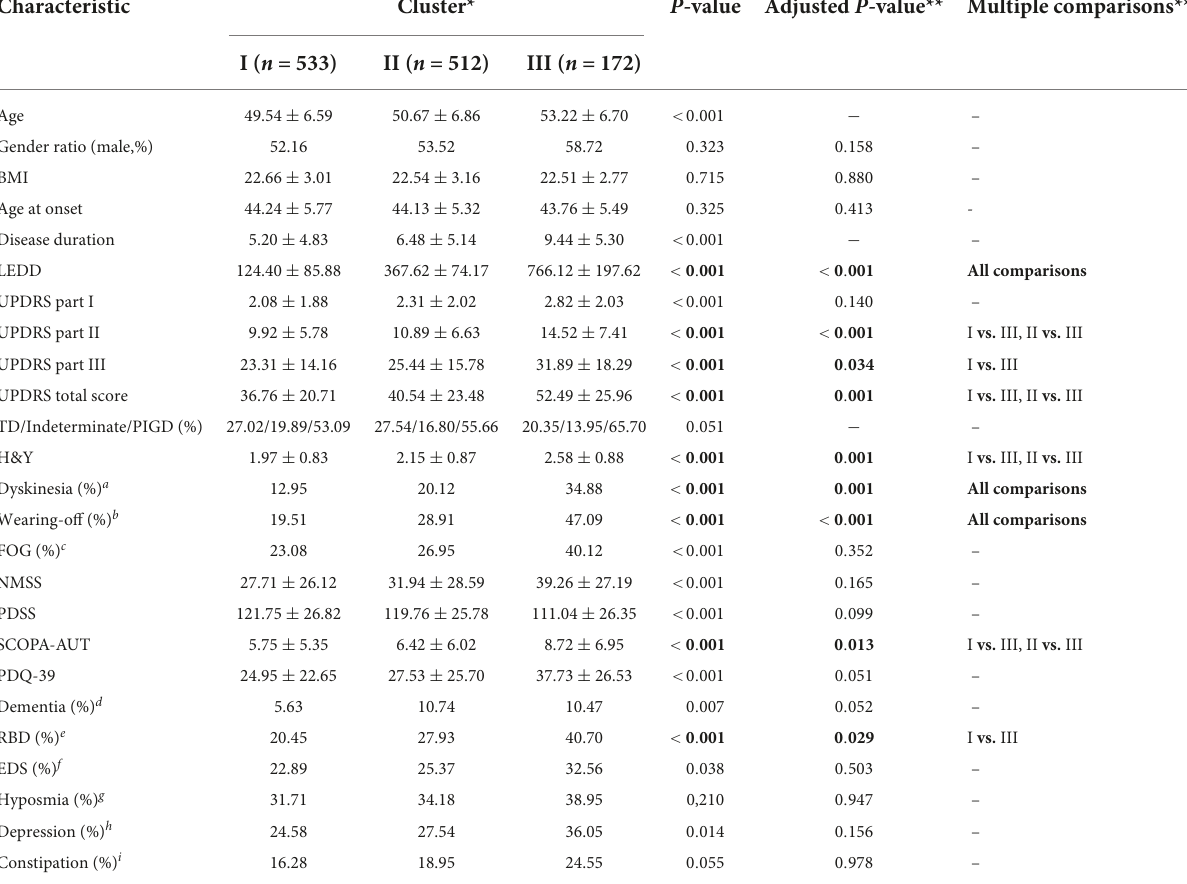
TABLE 1 Comparison of the baseline demography and clinical features between the three clusters of EOPD cohort based on hierarchical clustering solution.